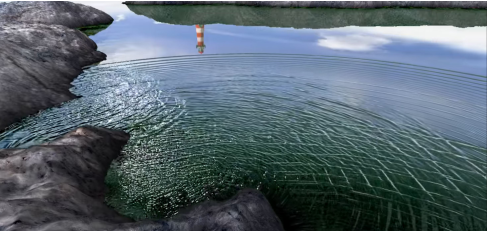
Figure 11. Effect of collisions between water and the solid boundary using the WPW [21]